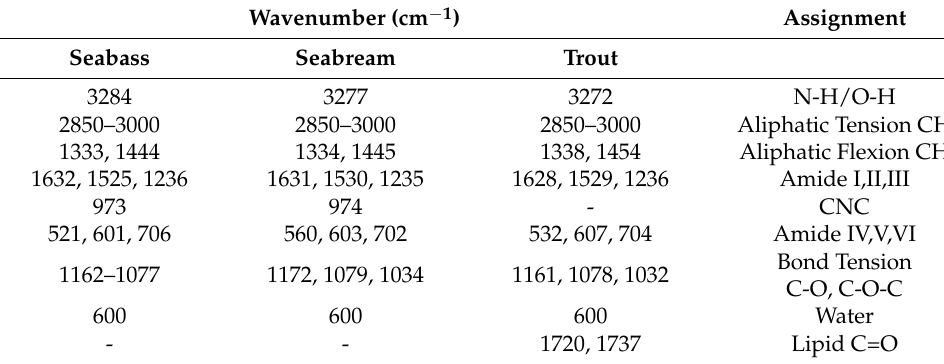
Table 5. Seabass, seabream and trout gelatins feature the following